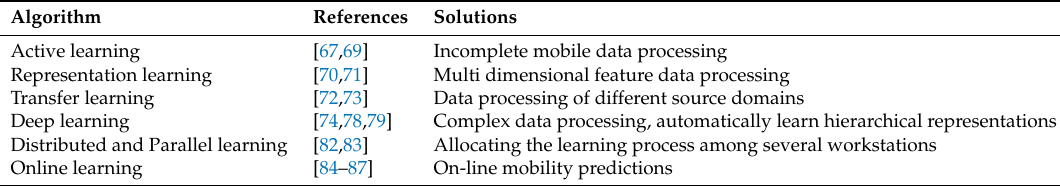
Table 4. Advanced Machine Learning